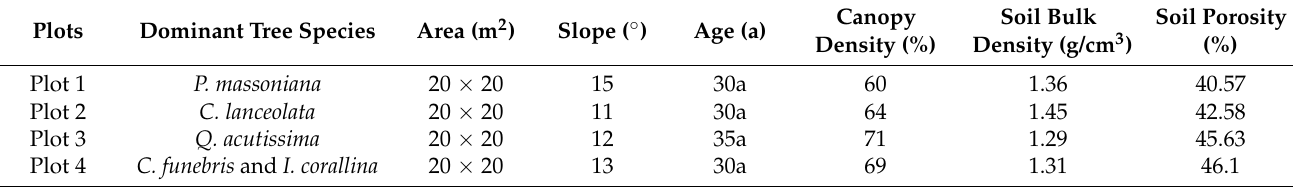
Table 1. Basic situation of the experimental